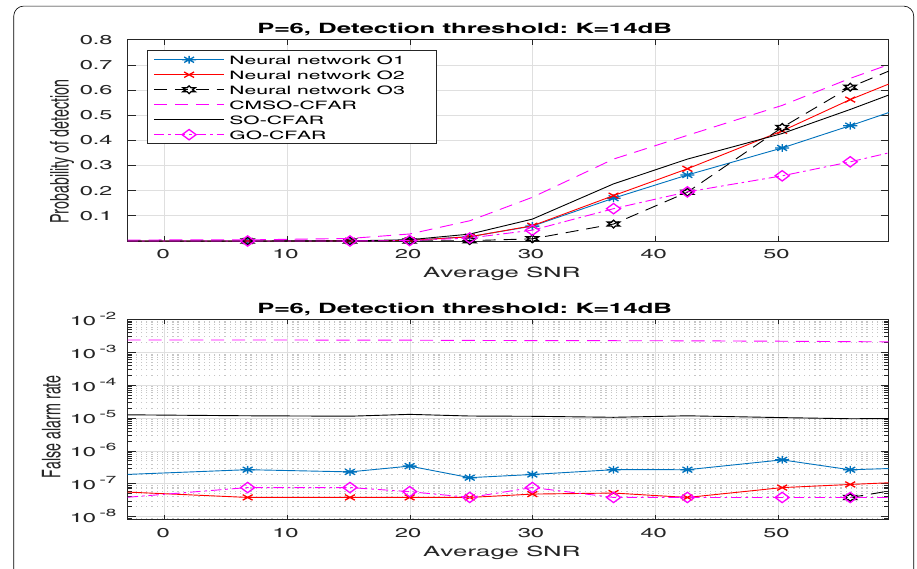
Fig. 5 P D and P FA , Noise-only scenario, 50 x 1 network, P =